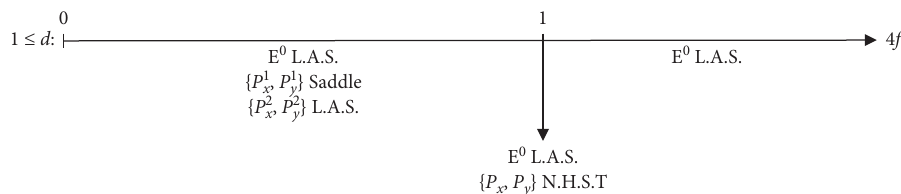
Figure 3: Bifurcation diagram of global dynamics of equation (1) in the parametric region 1 ≤ d for different values of the bifurcation parameter 4 fc